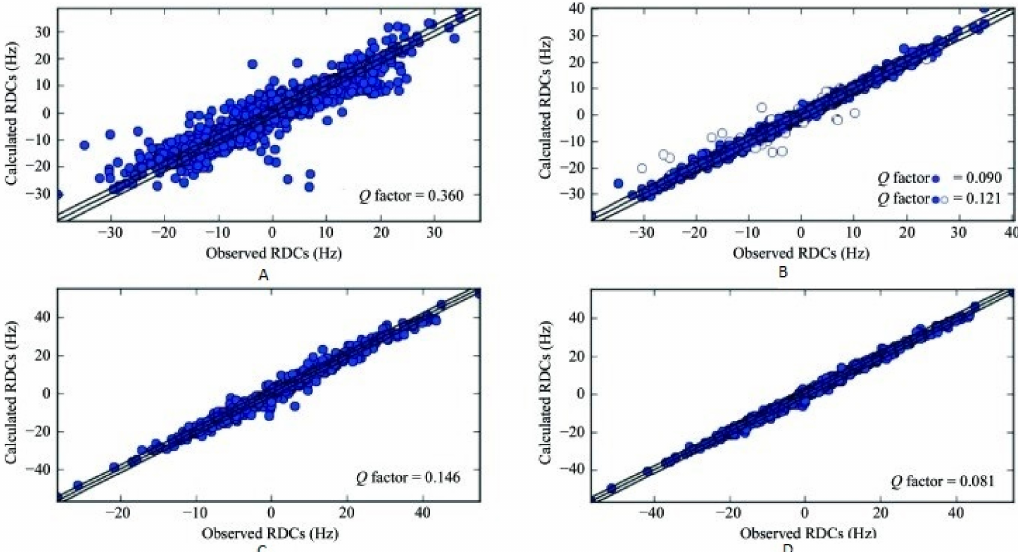
Figure 3. Calculated versus observed RDCs for ubiquitin ( A , B ) and GB3 ( C , D ) before ( A , C ) and after ( B , D ) joint refinement against RDCs and X-ray data. The empty symbols in ( B ) show the values for residues 8 and 72. Reproduced with permission from Ref. [101]